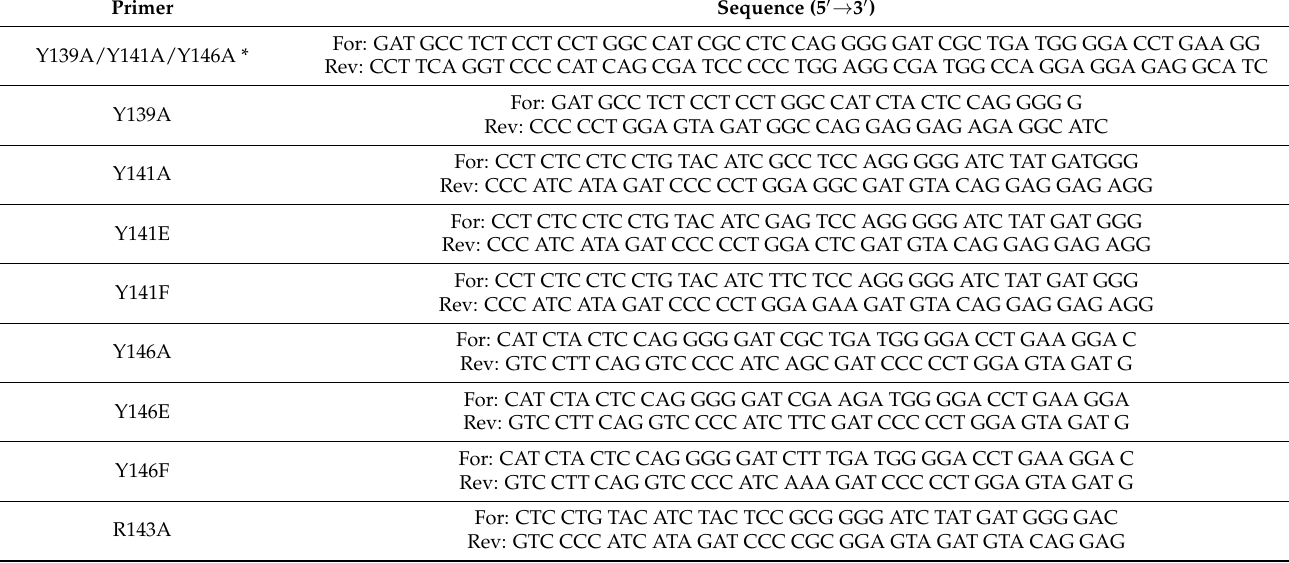
Table 1. Oligonucleotide primers used for site-directed mutagenesis of NTCP. Primer Sequence (5 (cid:48) → 3 (cid:48)